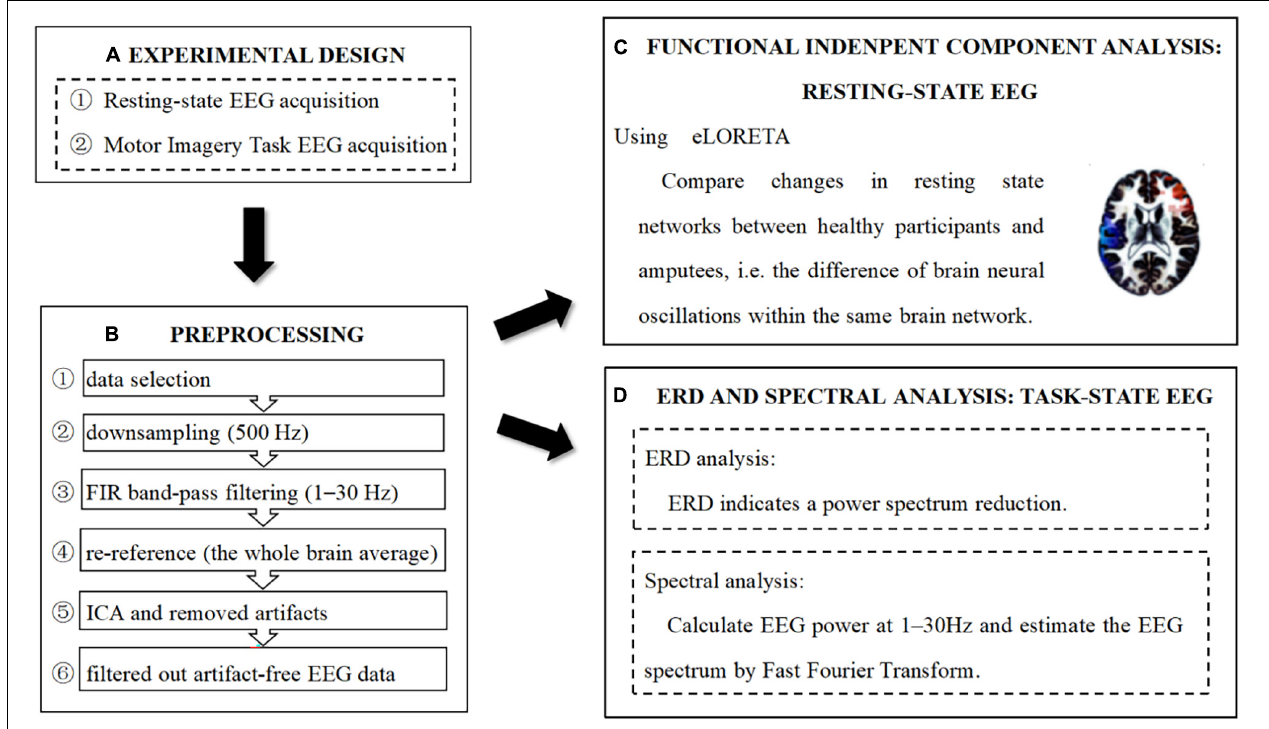
FIGURE 2 | Experimental design, preprocessing, and analysis pipeline. (A) Experimental design. (B) Preprocessing pipeline. (C) Functional independent component analysis: resting-state EEG. (D) ERD and Spectral analysis: task-state